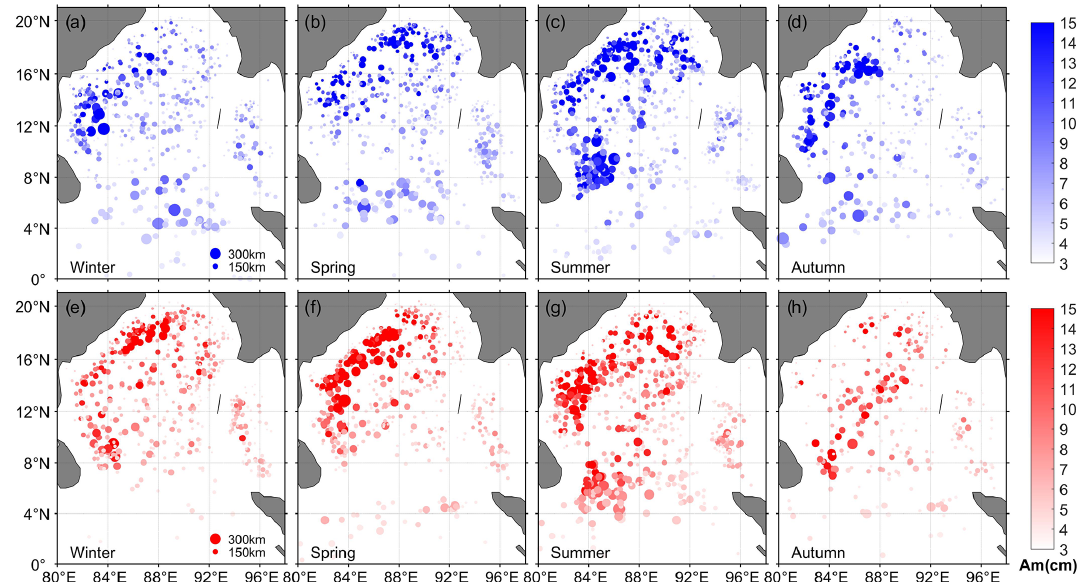
Figure 4. Seasonal spatial distribution of monthly cyclonic eddies (CEs, upper) and anticyclonic eddies (AEs, lower) based on monthly averaged sea level anomaly fields from January 1993 to February 2019 in the Bay of Bengal. Blue and red points represent CEs and AEs, respectively, where the color intensity represents the eddy amplitude (Am; unit: cm) and the size of the point represents eddy scale